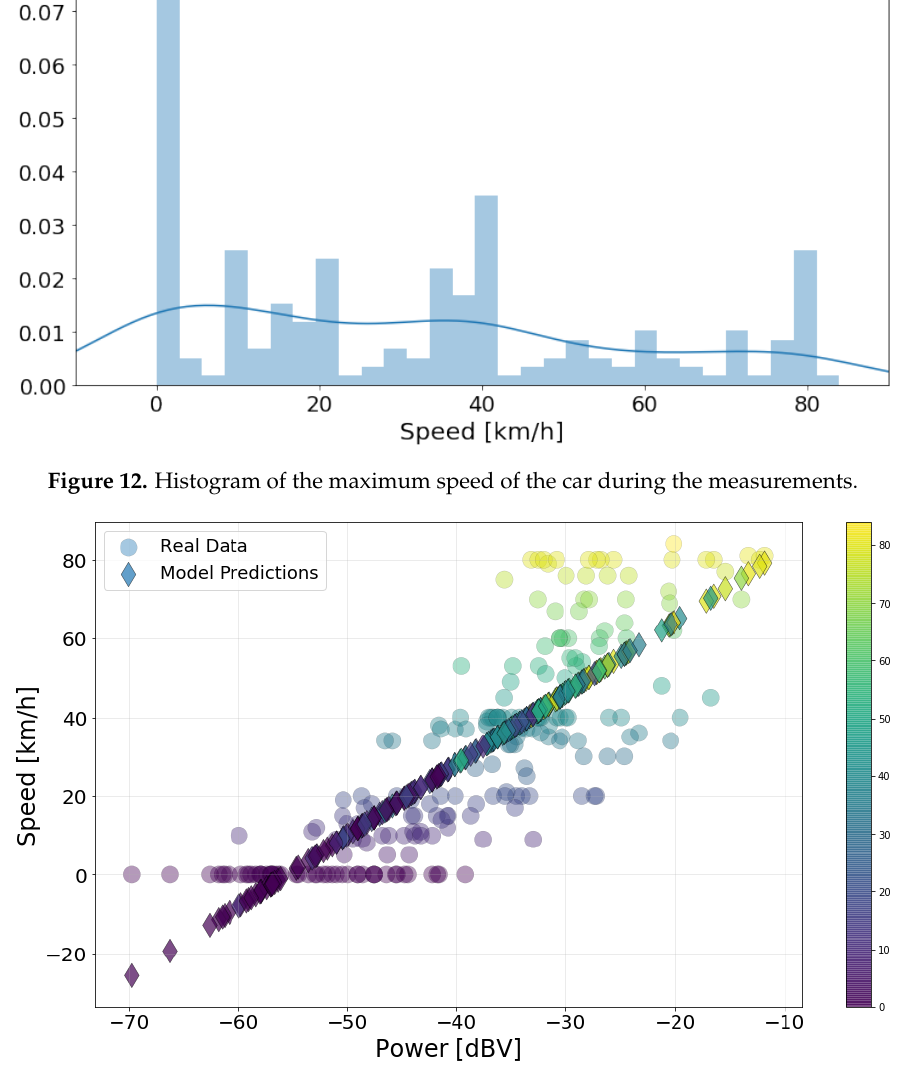
Figure 13. Speed data and predictions using the linear model. Table 9. Model coefficients (with confidence interval in parenthesis) and goodness of fit metrics for speed vs. power